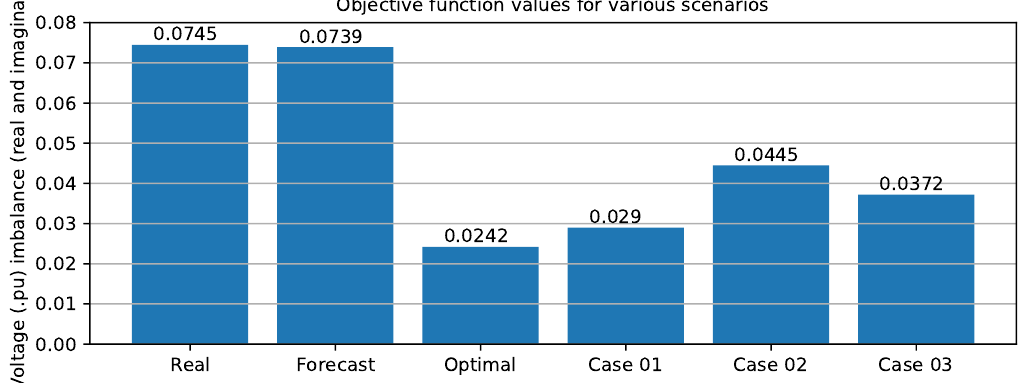
Figure 9. Objective function values for the three scenarios (see Section 4.1.3). Objective function values from Equation (2) are reduced to voltage (p.u.) for better understanding of